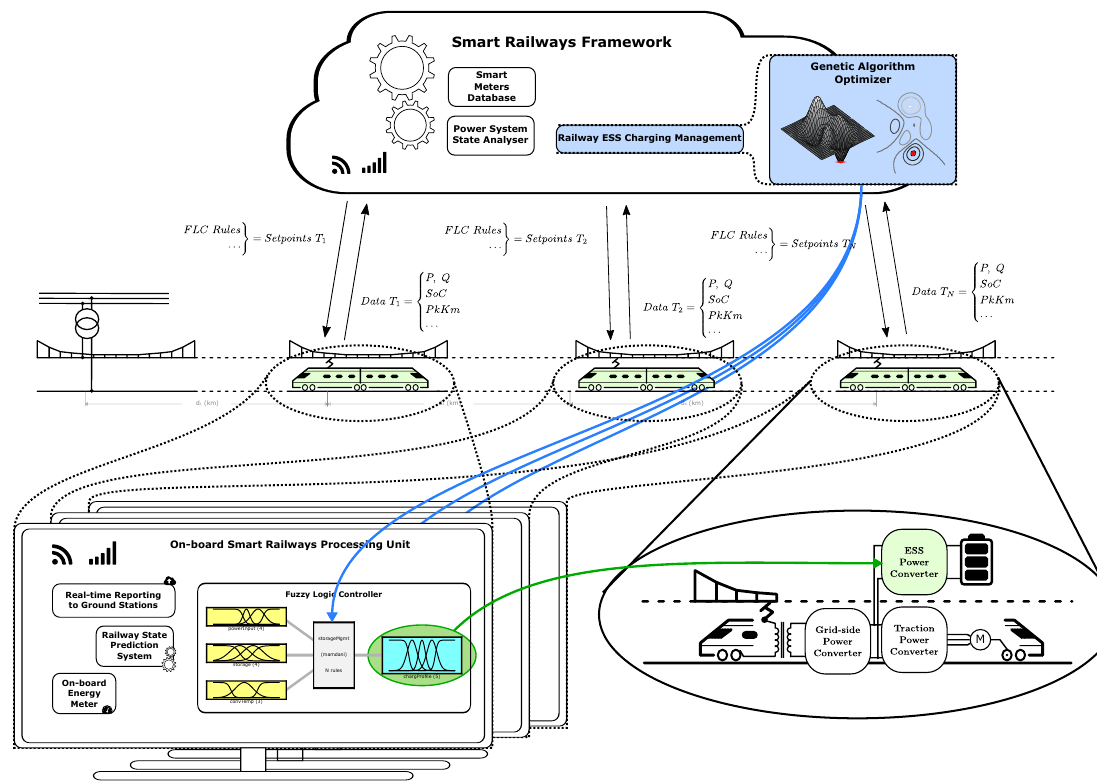
Figure 15. Smart railways framework to support the railway on-board charging strategy for multiple